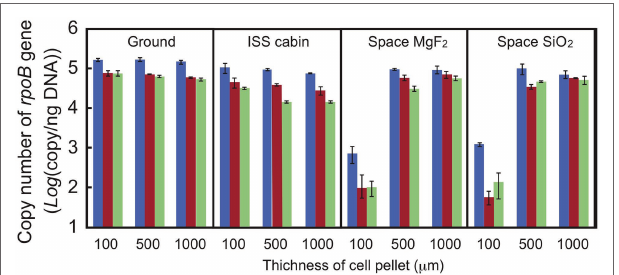
FIGURE 5 | Copy number of the intact rpoB gene in DNA prepared from D. radiodurans R1 cell pellets of different thicknesses. The intact rpoB gene (887 bp) in genomic DNA was amplified and quantified by quantitative PCR (qPCR). Blue, brown and pale green bars represent 1-, 2-, and 3-year exposed samples, respectively. Each error bar shows the SEM of triplicate samples.